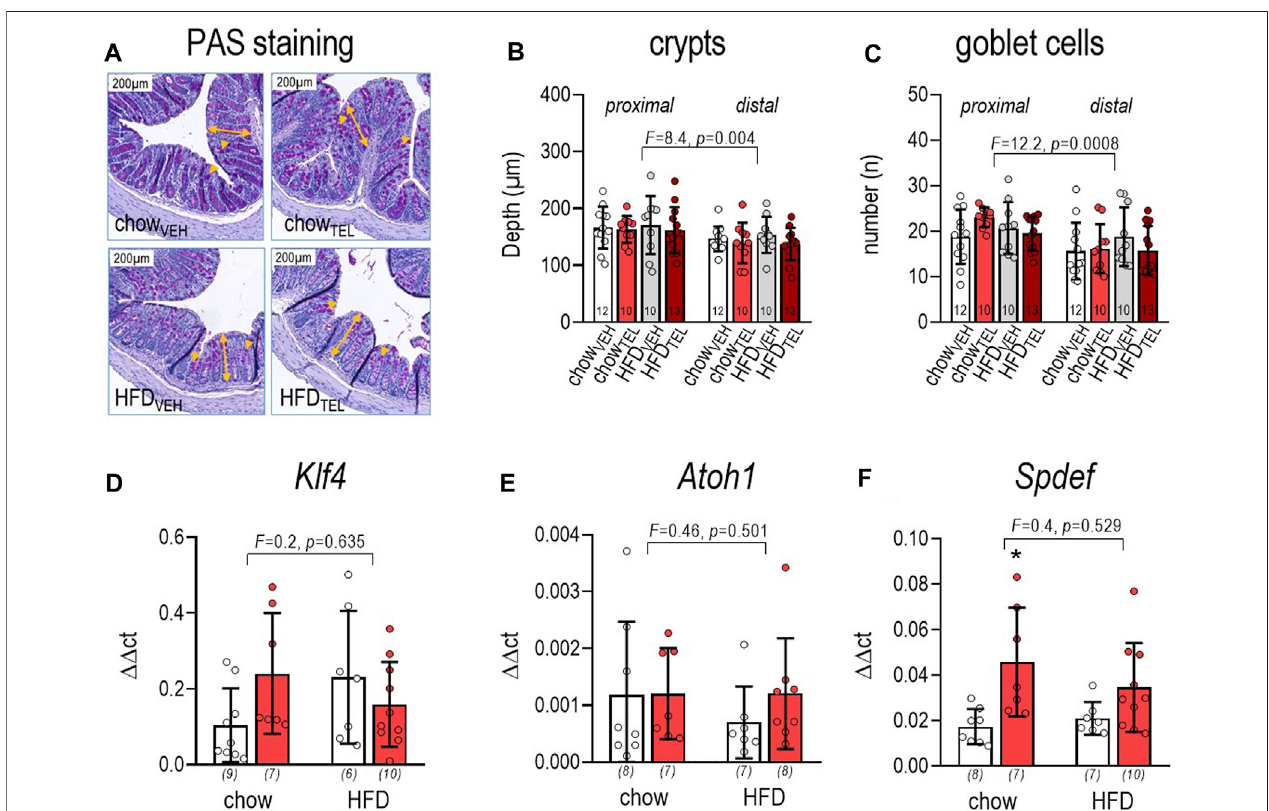
FIGURE 4 | Effect of TEL ( C , 8 mg/kg/day red bars) or vehicle treatment open bars (O) on large intestine of mice that were fed either with chow or high fat diet (HFD). (A) PAS staining, the yellow double arrows indicate depth of crypt, while yellow arrows indicate goblet cells depths of crypts were only measured in fully visible symmetric crypts; (B) depth of crypts, the respective crypt depth was measured in 10 de fi ned crypts per image by considering four images per animal (three-way ANOVA; diet: F = 0.1, p = 0.774; TEL: F = 1.4, p = 0.239); (C) number of goblet cells; number of goblet cells within one crypt was counted in 10 crypts per image (three-way ANOVA; diet: F = 0.1, p = 0.795; TEL: F = 0.1, p = 0.882); (D) klf4 expression (two-way ANOVA; TEL: F = 0.5, p = 0.49); (E) atoh1 expression (two-way ANOVA;TEL: F =0.54, p =0.467); (F) Spdef expression (two-wayANOVA; TEL: F =12.7, p =0.001); means±SD; theindividualgroupsizeisindexed belowthebars in brackets;.* p < 0.05 vs. chow VEH